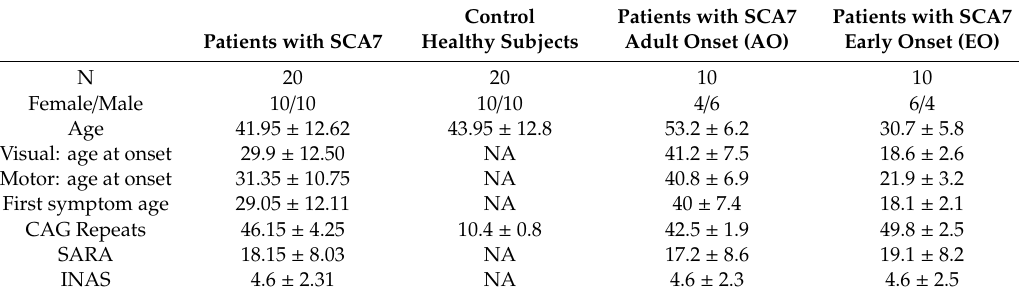
Table 1. Demographic and Clinical Features of Studied